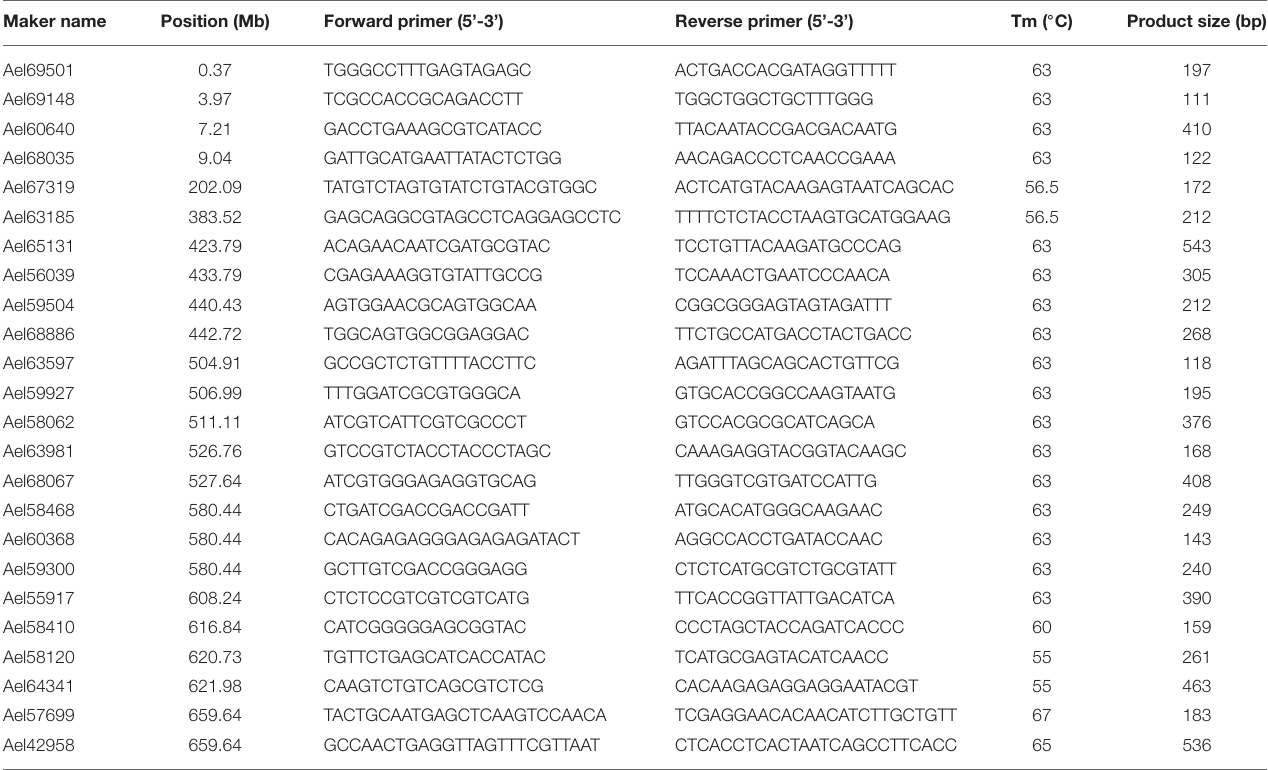
TABLE 2 | Ae. longissima 6S l #3 specific markers developed in this study.